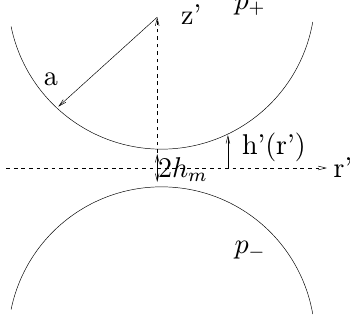
Fig. 1 – Slide view of the two indentical particles under